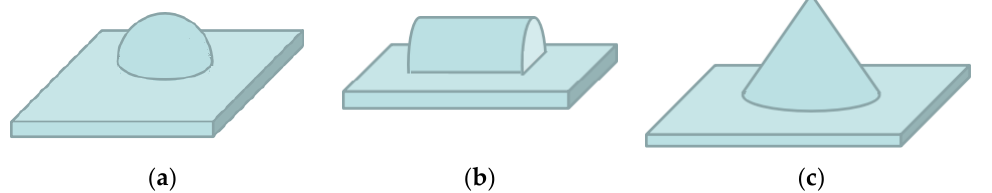
Figure 1. Shape of 3D microstructures with a sidewall of approximately curved surfaces: ( a ) hemisphere; ( b ) semicylinder; ( c ) cone.